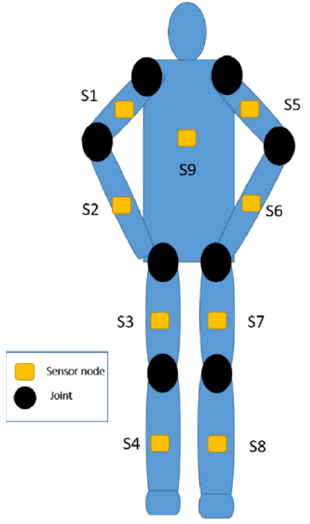
Figure 2. Top view of sensor nodes ( left ); the wearable sensor node ( right ).